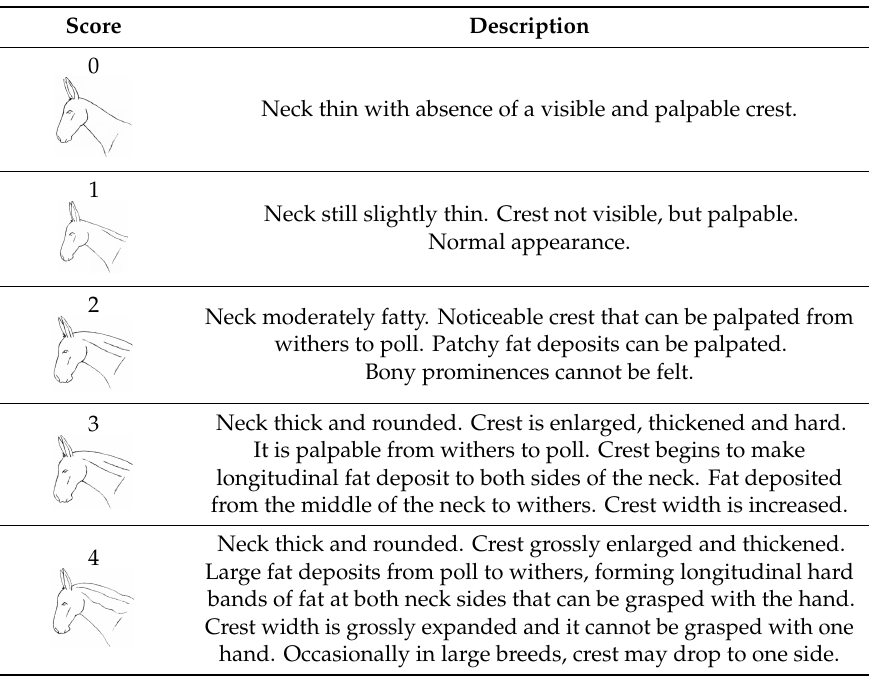
Table 2. Donkey-specific neck scoring system provided by Mendoza et al. (2015) [20].